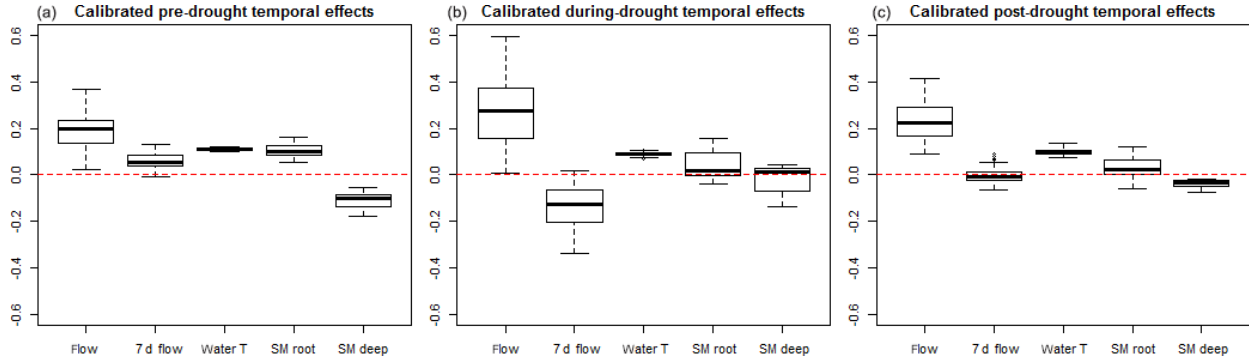
Figure 9. The effects of the five key predictors of the temporal variability in TSS across the 102 sites summarized by the posterior mean of the calibrated parameter values for each predictor (box shows values across all sites): flow, 7d antecedent flow, water temperature, root zone soil moisture and deep soil